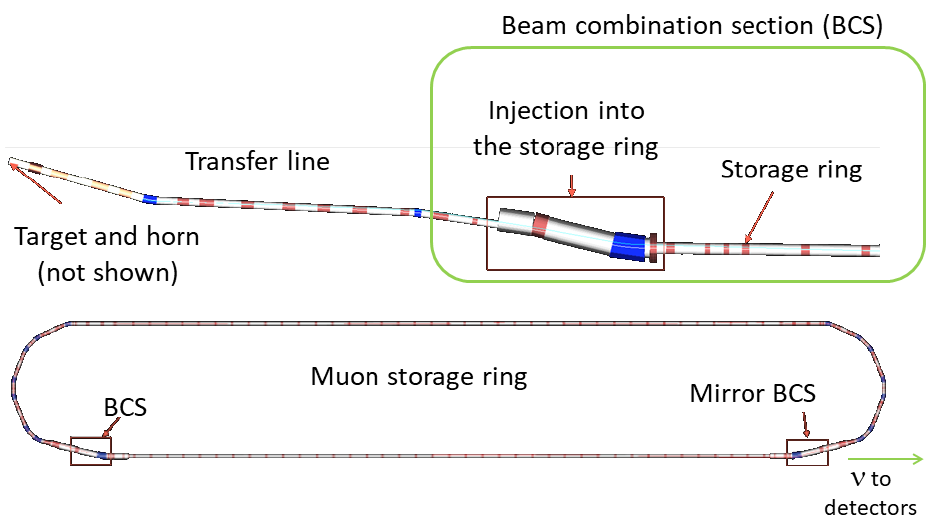
Figure 11. Schematics of the nuSTORM facility. ( top ) the pions focused upstream by a horn (not shown) are transported and injected into the storage ring. ( bottom ) the storage ring made of a large acceptance lattice with quadrupoles and bending dipoles. The muons from pion decays produce neutrinos of both electron and muon flavor mostly in the straight session. The Beam Current Transformer is located inside the beampipe of the storage